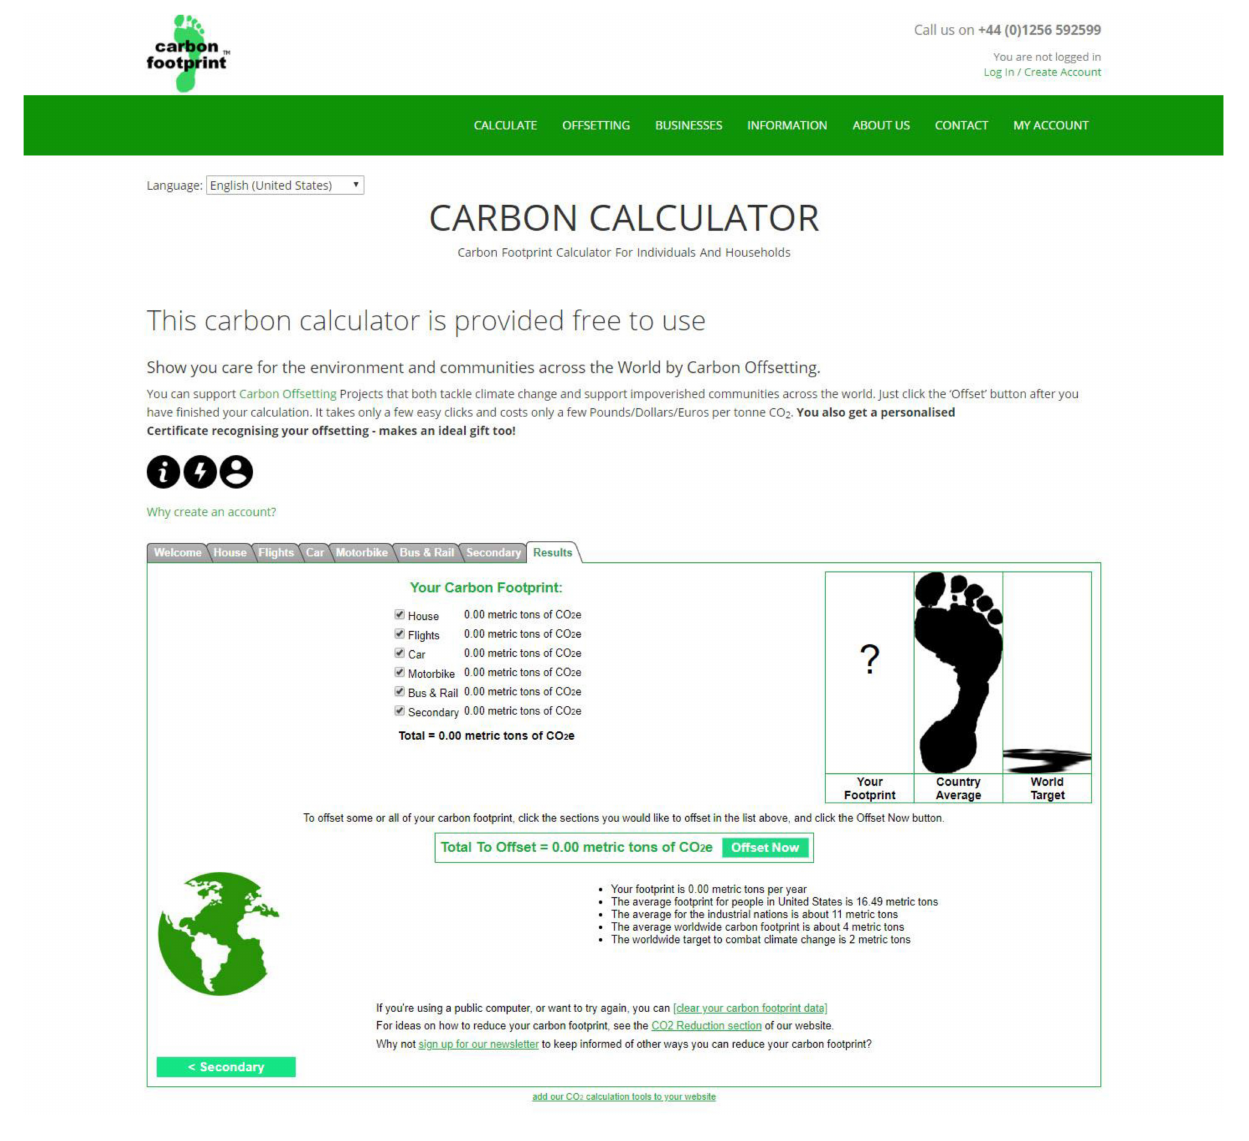
FIGURE 2 | Your carbon footprint results